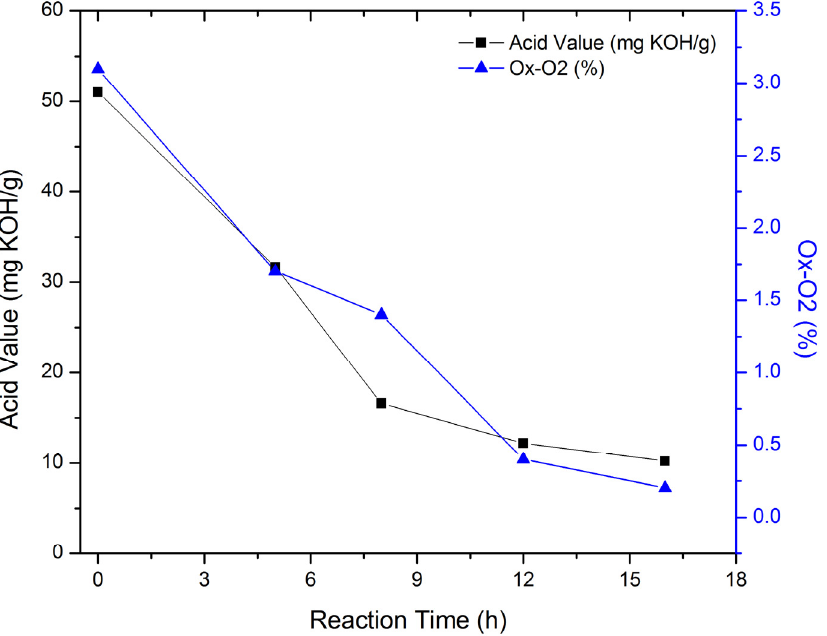
Figure 1. EPOLA Synthesis, Acid values and O x -O 2 (%) vs Acrylation Reaction Time.